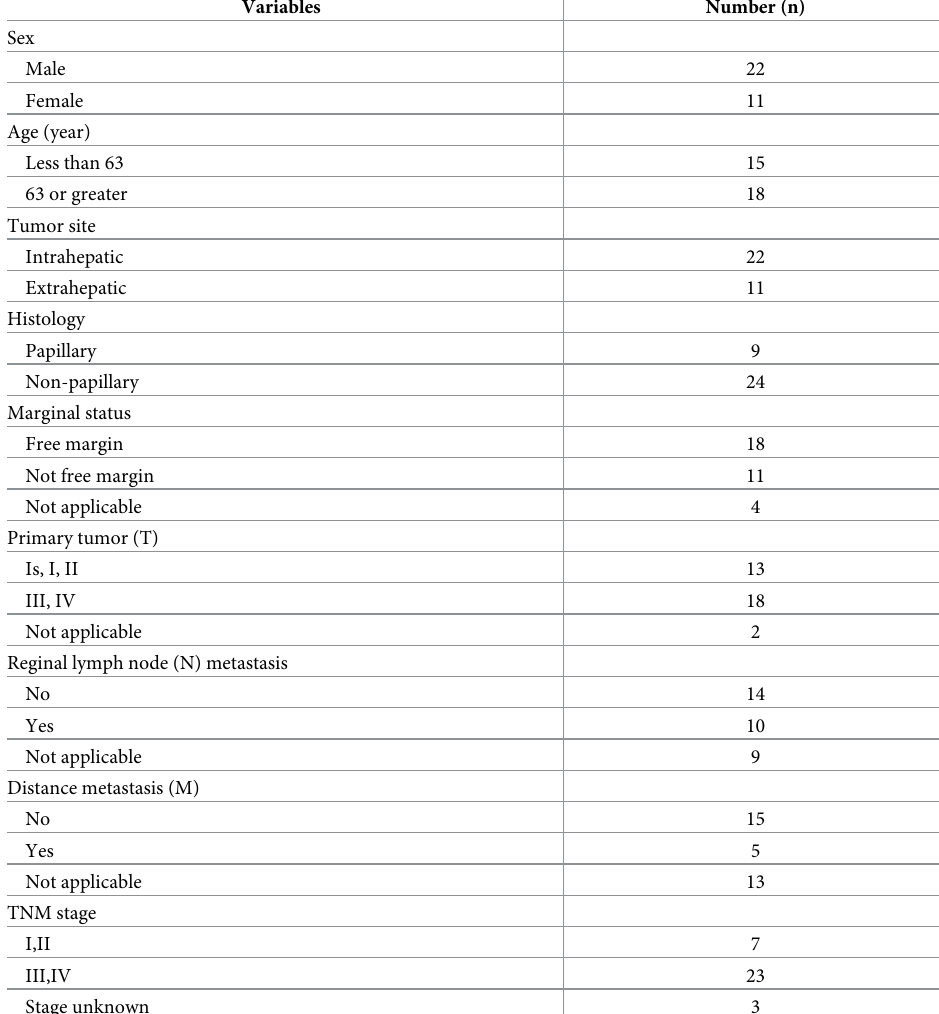
Table 2. The characteristics of all CCA patients for whom the tumor was tested with cisplatin using HDRA. Variables Number